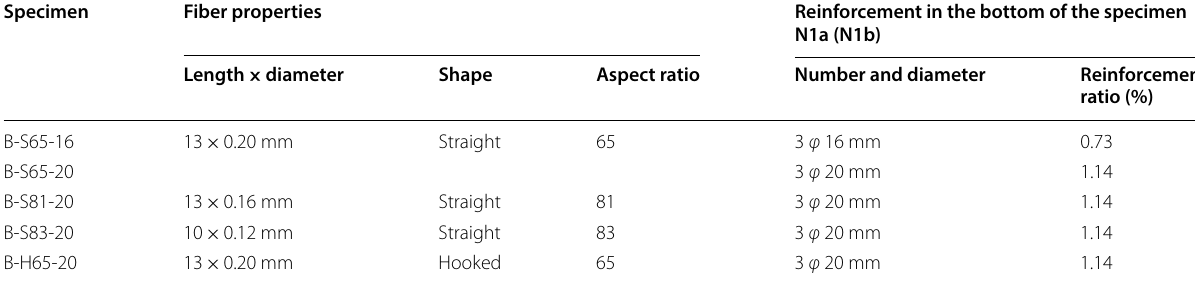
Table 3 Details of